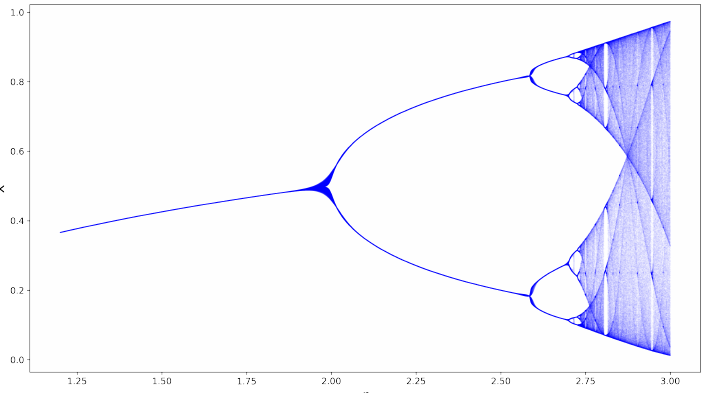
− 1 2 n ( 1 − x n ) 1 + 1 2 (log-logistic-2), see